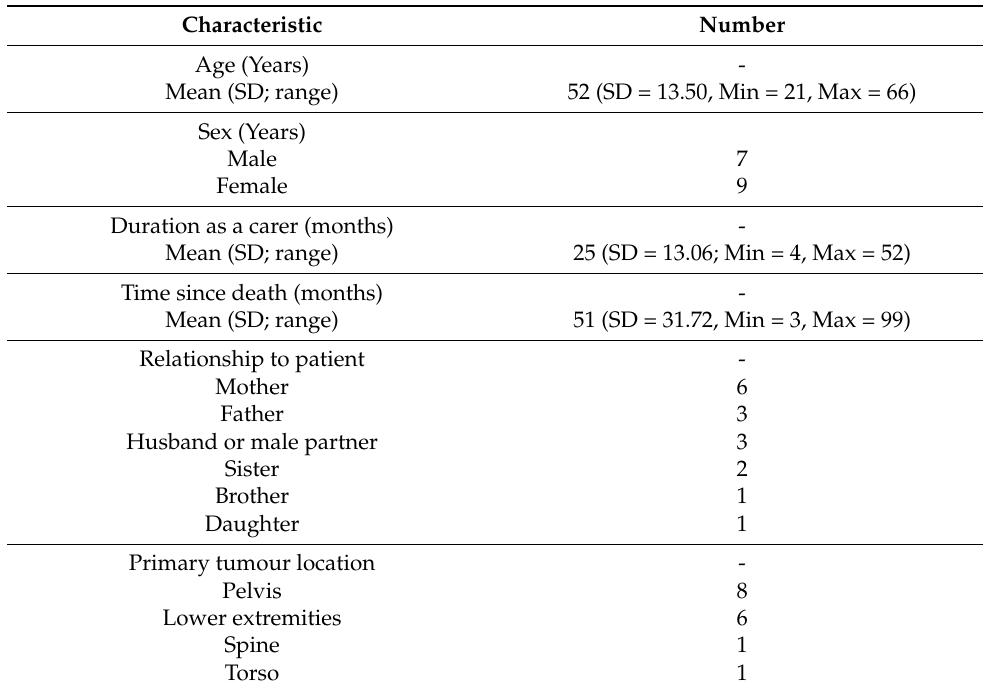
Table 1. Bereaved Carer Demographics (n =